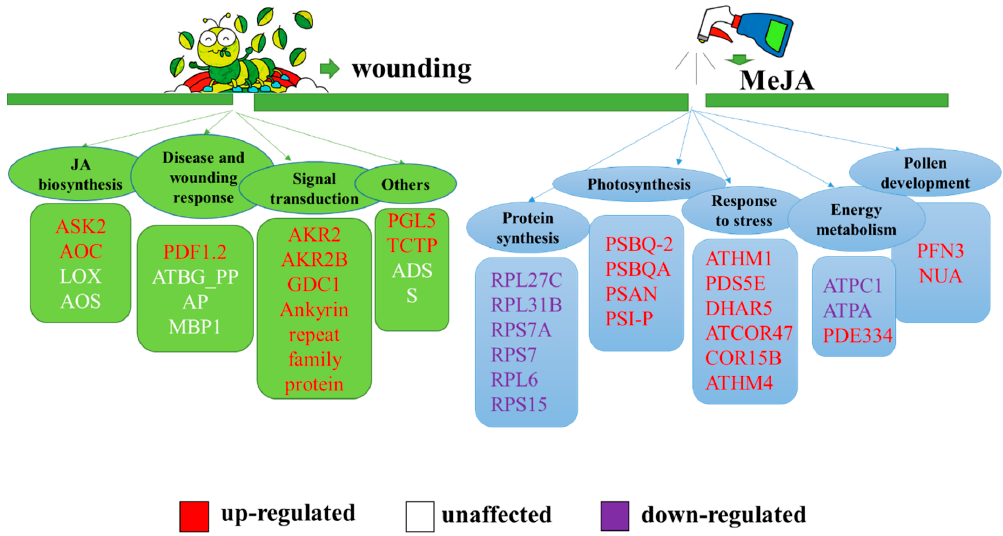
Figure 5. Summary of the biological processes affected by exogenous MeJA in the absence of endogenous jasmonic acid (JA). The red: up-regulation of protein expression; white: no significant change; purple: down-regulation of protein expression. Green group: proteins affected by JAs reported previously; blue group: proteins affected by jasmonates (JAs) discovered in this study. Orange group: plant hormone affected by JAs in this study.